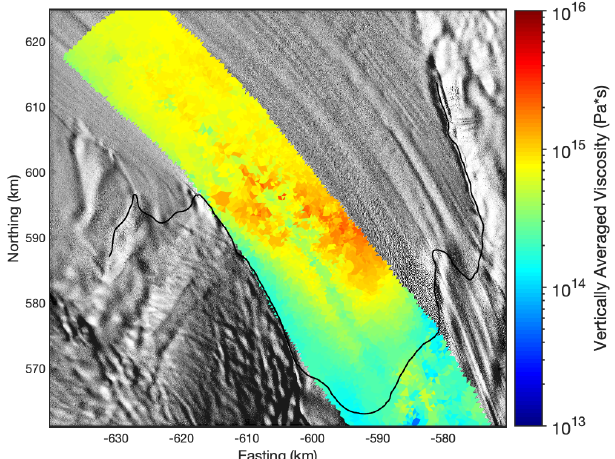
Figure B2. Ice viscosity in the melt channel area obtained from in- verse modeling. The map extent is the same as in Fig. 1. The back- ground image is a hillshade of the Reference Elevation Model of Antarctica (Howat et al., 2018,